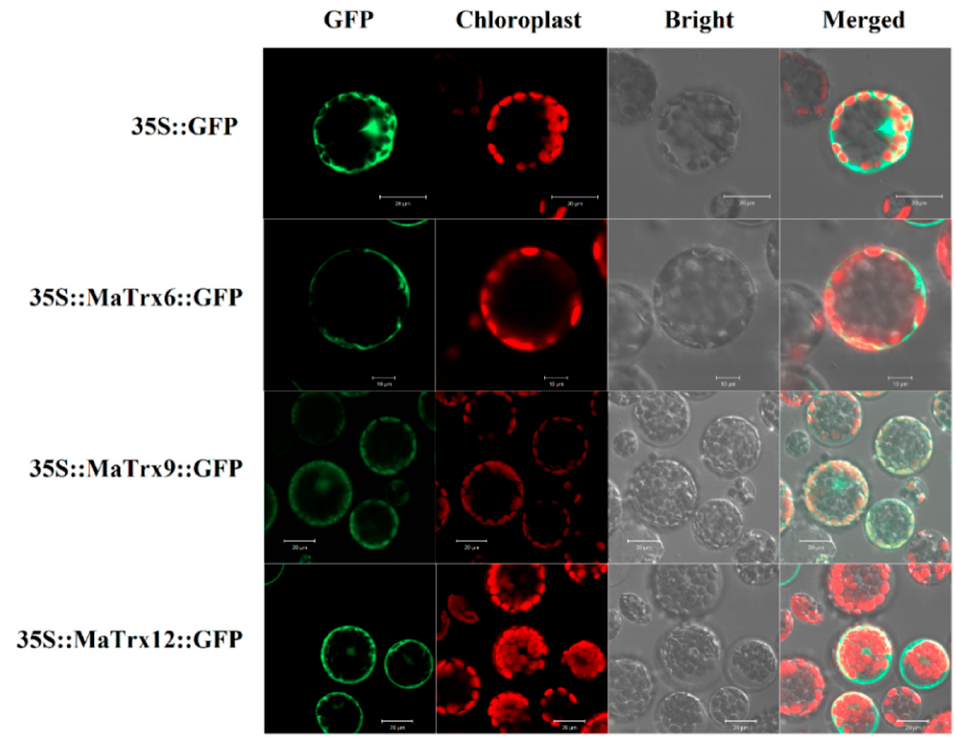
Figure 3. Subcellar localization of MaTrx6, MaTrx9 and MaTrx12 in Arabidopsis protoplast. The green fluorescene from three proteins merged with bright field and red fluorescene from the chloroplast using confocal microscopy. GFP: green fluorescent protein. In 35::GFP, 35S::MaTrx9::GFP and 35S::MaTrx12::GFP, the scale bar = 10 μ m. In 35S::MaTrx6::GFP, the scale bar = 20 μ m.